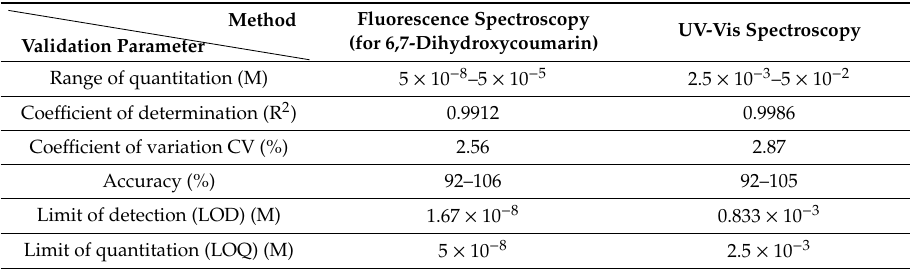
Table 1. Analytical characteristic of calibration graph reflecting the relationship between the relative fluorescence enhancement of 6,7-dihydroxycoumarin and the concentration of 4-amino-TEMPO compared with spectrophotometric method (absorbance of 4-amino-TEMPO measured at λ max = 375